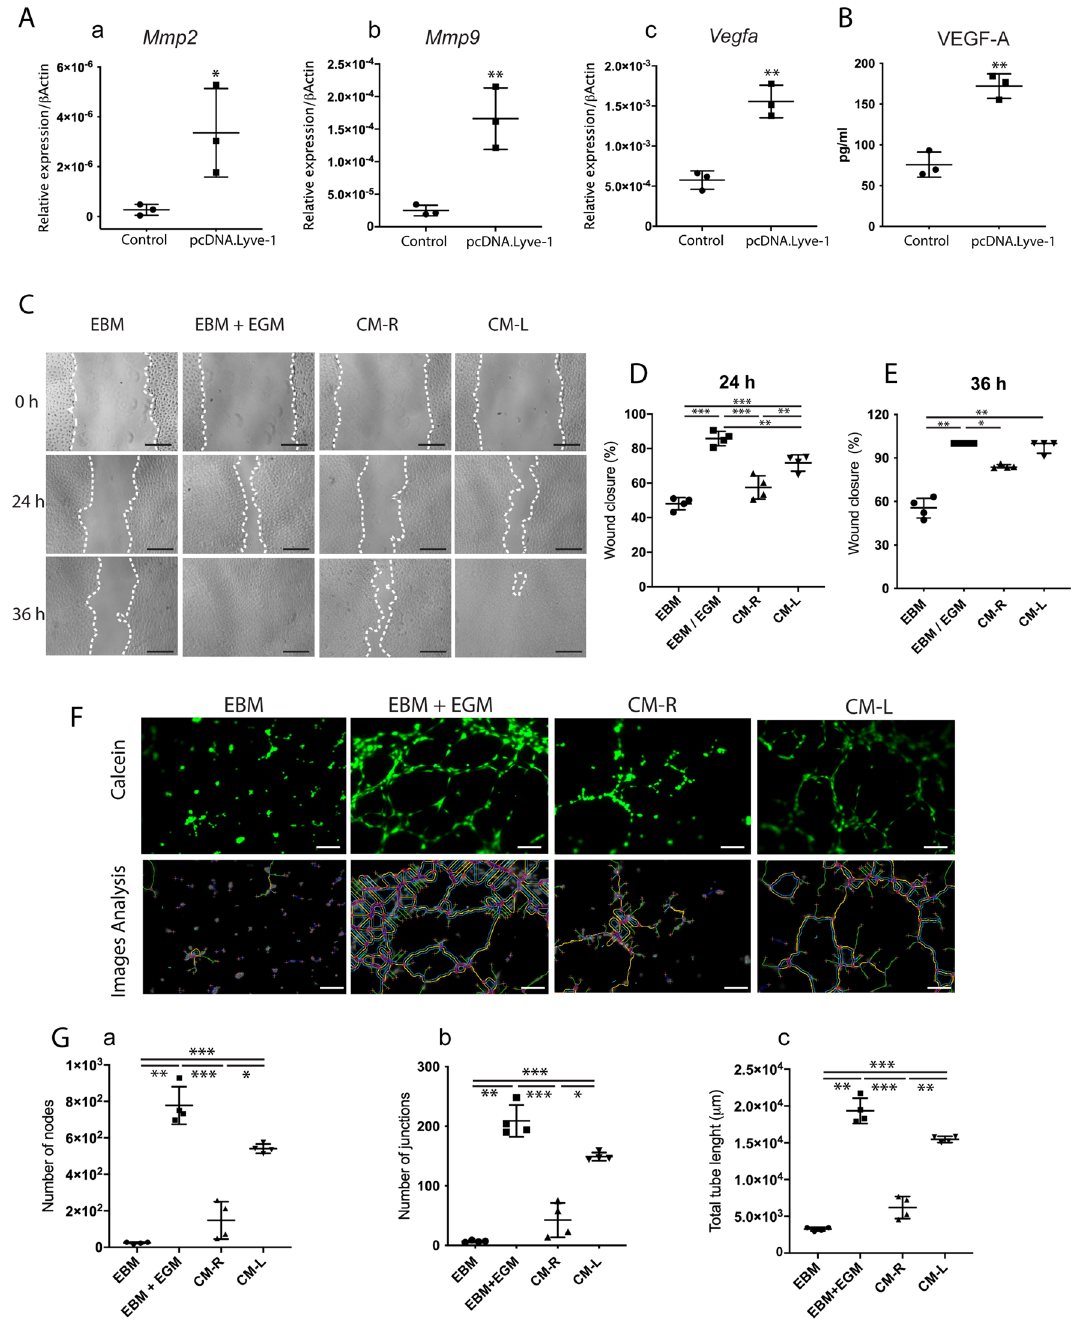
Figure 5. LYVE-1-expressing macrophages promote the migration and tube formation of human umbilical vein endothelial cells (HUVECs). A Lyve1- expression vector was transfected into RAW264.7 cells to generate Lyve1 - expressing macrophages. ( A ) RT-PCR analysis of angiogenesis-related genes ( Mmp2, Mmp9 , and Vegfa ) in RAW264.7 cells and Lyve1 -expressing macrophages (mean ± SD, n = 3). ( B ) Quantification of VEGF-A in conditioned medium from Lyve1 -expressing macrophages (CM-L) and RAW264.7 cells (CM-R) by ELISA (mean ± SD, n = 3). ( C ) Scratch wound healing test for HUVECs. The confluent cell monolayer of HUVECs was scratched with 200-μl pipette tips. Conditioned media (CM-L, CM-R), EBM-2 supplemented with EGM-2 (EBM/EGM), or serum-free EBM-2 (EBM) were added to culture plates. ( D , E ) Percentages of closure of scratched area at 24 h (mean ± SD, n = 4) and 36 h (median with interquartile range) after the initial scratch. Scratched areas were measured using an optimized plugin for ImageJ. ( F ) HUVEC tube formation assay. HUVECs were resuspended in conditioned media (CM-R, CM-L), EBM/EGM, or EBM. Cell suspension was seeded onto the solidified ECM gel and incubated for 6 h. Lower panels show the detection of tube-like structures of the corresponding upper panels using ImageJ. ( G ) The numbers of nodes and junctions and total tube length were quantified by ImageJ (mean ± SD, n = 4). Scale bars 300 µm ( C ) and 100 µm. Data were collected from 2–3 independent experiments to obtain consistent results. Data were statistically analyzed by unpaired Student’s t -test ( Aa–c , B ), one-way ANOVA and Tukey’s post hoc test ( D ), Kruskal–Wallis test and Dunn’s post hoc test ( E ), or Brown-Forsythe and Welch ANOVA test and Dunnett’s T3 post hoc test ( Ga–c ). * p < 0.05, * p < 0.01, and *** p <